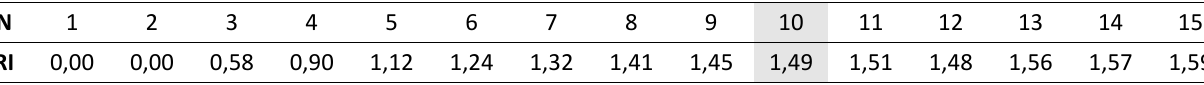
Table 3. AHP validity reliability